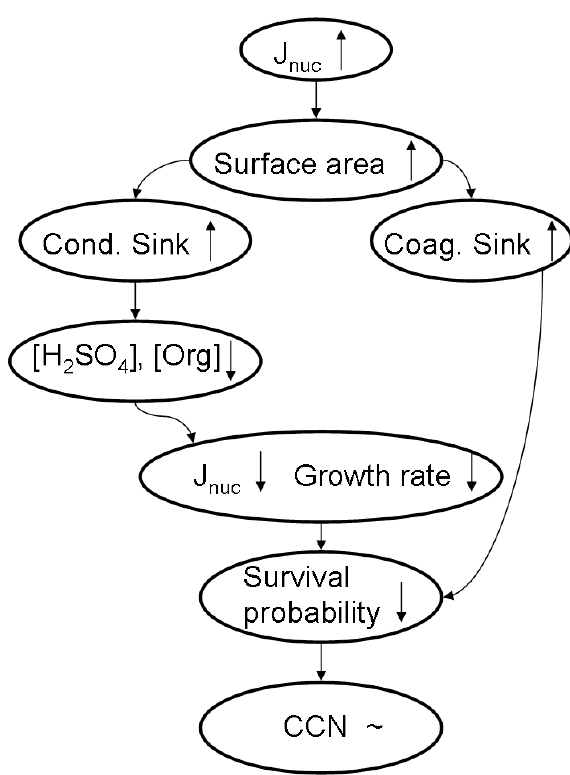
Figure 5. Flowchart of microphysical feedbacks that decrease sur- vival probability with increasing nucleation rates, limiting the for- mation of CCN from nucleation